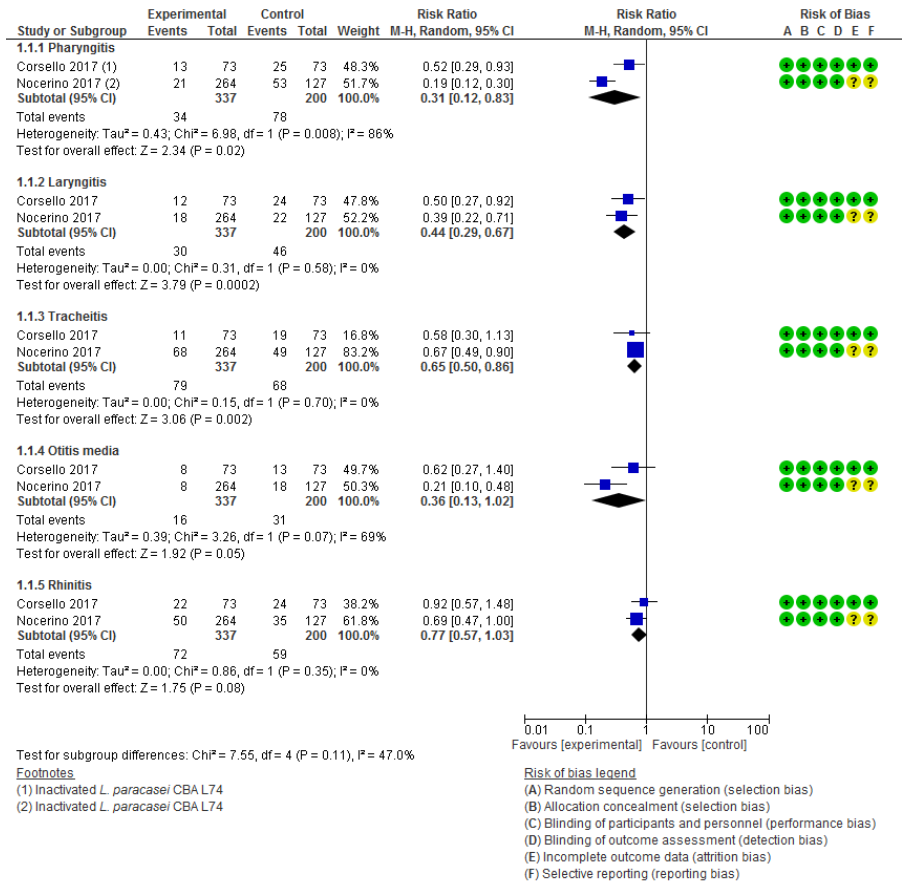
Figure 5. Effect of postbiotic supplementation (heat-inactivated L. paracasei CBA L74) on preventing respiratory tract infections.